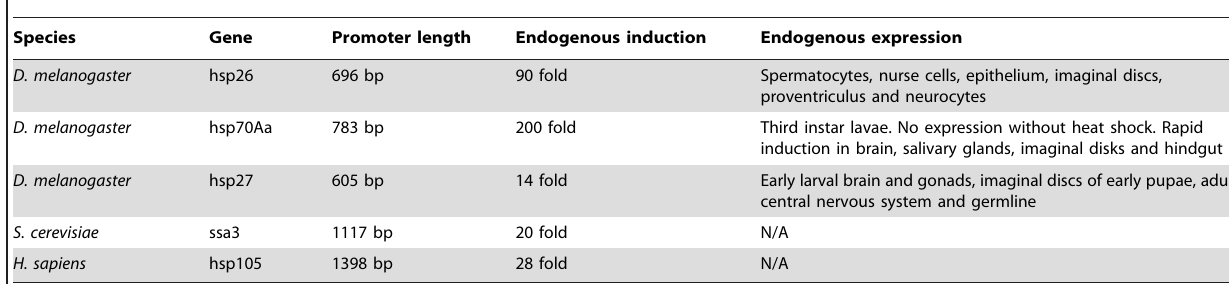
Table 1. Heat-shock inducible genes examined in this study.